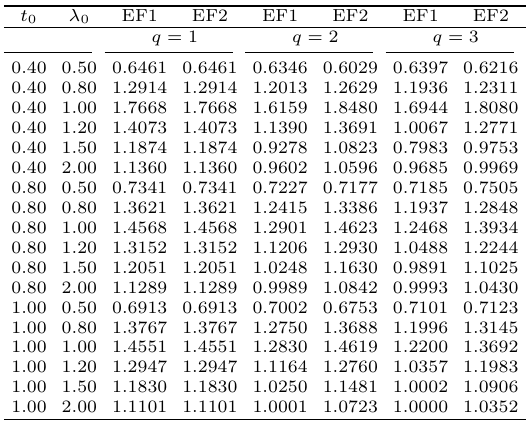
Relative efficiencies of the estimators of (cid:21) q (when (cid:21) = 1 ) under Type I